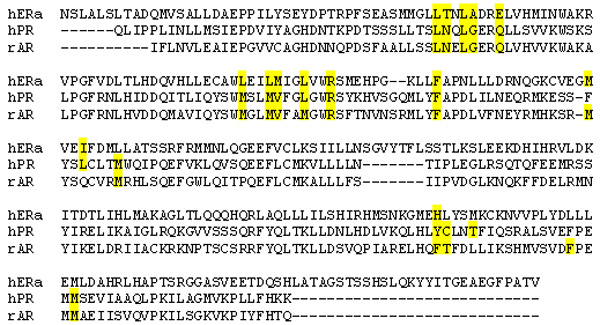
Multiple alignment of the ligand binding domains of (hERα), (hPR) and (rAR). Residues involved in ligand interactions are highlighted in yellow.